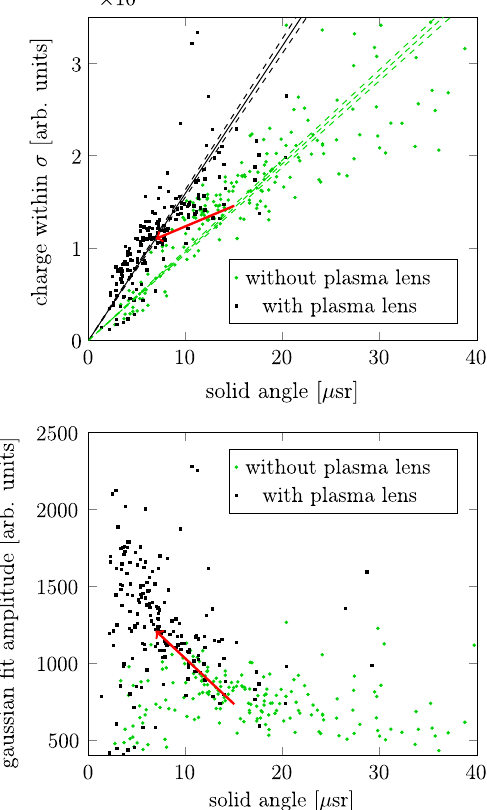
FIG. 4. Single shot data analysis of the plasma lensing effect: Each dot represents a single laser shot without the plasma lens (green) or with the plasma lens in operation (black). The shift of the point clouds is clearly visible. The same data sets are shown in Figs. 2(a) (green, no plasma lens) and 2(b) (black, plasma lens density 1 . 6 × 10 19 = cm 3 ). The red arrows therefore indicate the values obtained from the averaged analysis in Fig. 2. The gap ¼ 8 . 75 mm Top: As the average solid length was constant at L g angle reduces from 16 μ sr to 6 . 8 μ sr, the charge in the beam ’ s central region drops to 75%. A linear fit reveals the increase of the beam ’ s angular fluence from ð 96 (cid:3) 2 Þ × 10 3 ½ a : u : (cid:2) to ð 160 (cid:3) 4 Þ × 10 3 ½ a : u : (cid:2) with the lensing stage enabled. The dashed lines show the standard deviation of the fit. Bottom: Together with the reduction of the solid angle an increase in the amplitude of the 2D Gaussian fit by a factor of 1.65 is